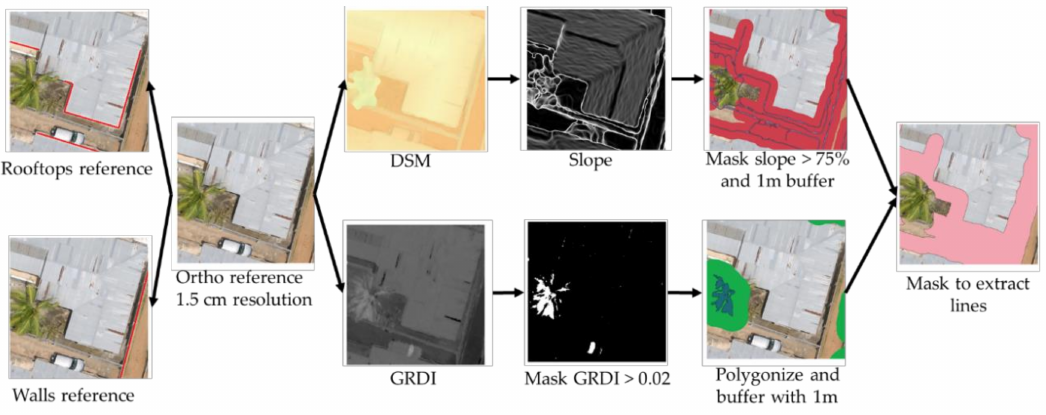
Figure 4. Workflow to define reference lines and a search mask for lines representing concrete walls and